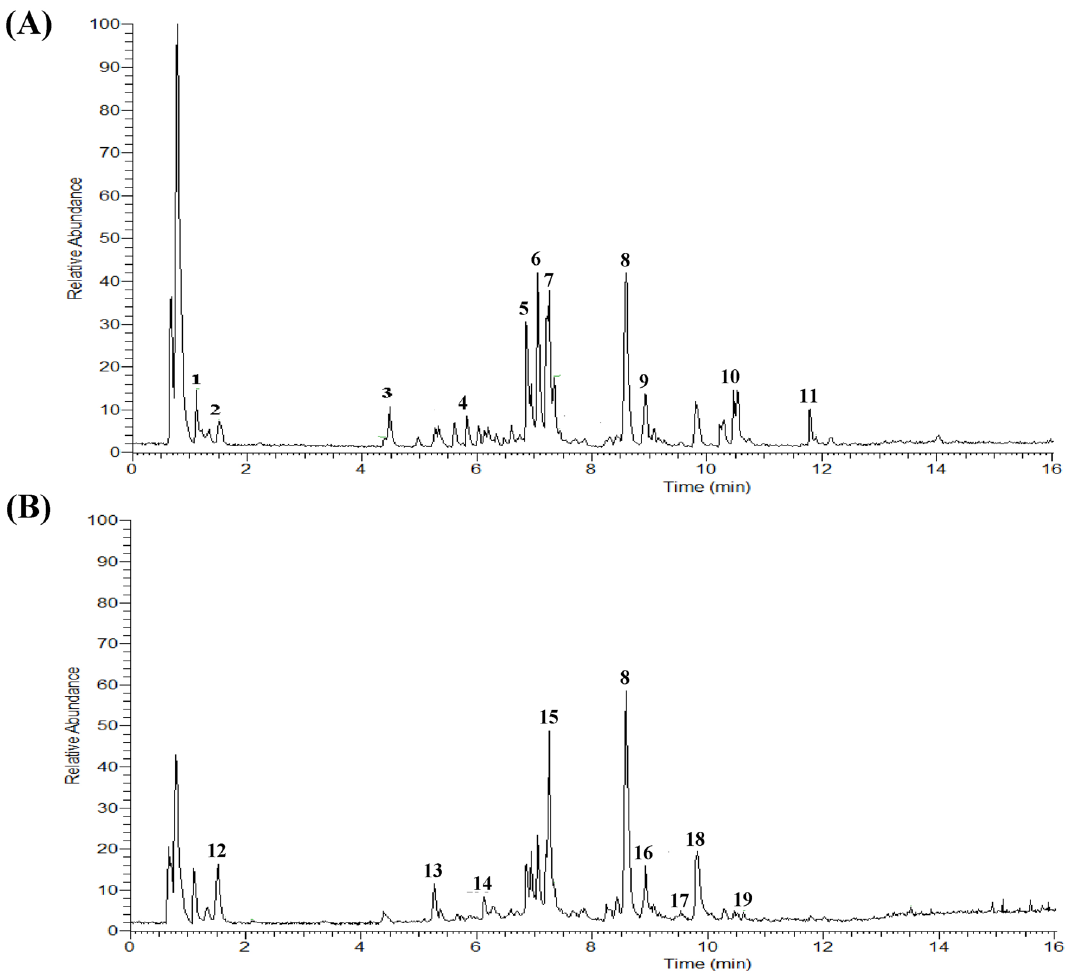
Figure 6. UPLC/Q-TOF-MS analysis of Chuan Xinlian. ( A ) Chromatograms of Chuan Xinlian in positive ESI mode; and ( B ) chromatograms of Chuan Xinlian in negative ESI